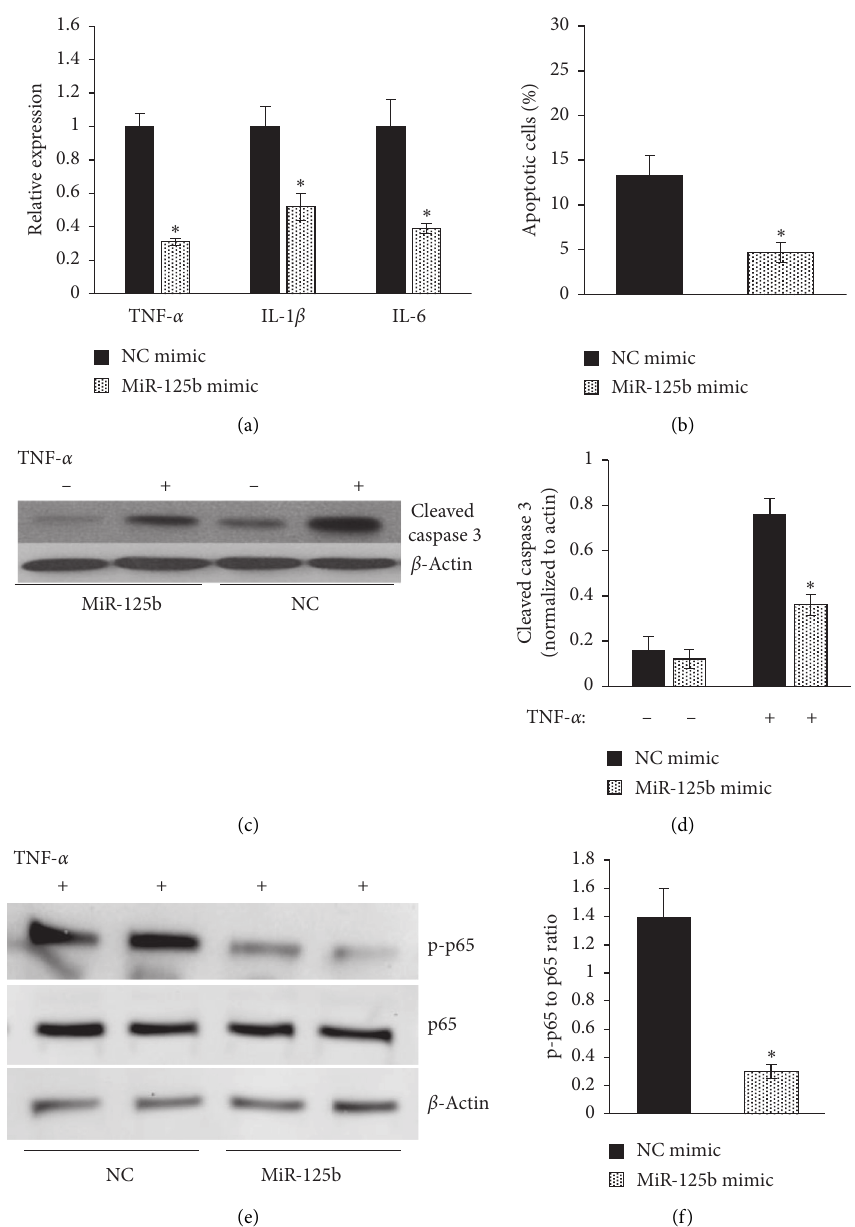
Figure 2: Upregulation of miR-125b in EPCs attenuated the expression of proinflammatory factors and ameliorated the TNF- α -induced cell apoptosis. EPCs were treated with TNF- α (10ng/mL) for 1h after transfection. The mRNA levels of proinflammatory factors (TNF- α , IL-1 β , and IL-6) were measured by qRT-PCR (a). Cell apoptosis was determined by flow cytometry using annexin V staining (b). The activation of caspase3 was analyzed by western blotting. Representative (c) and quantification (d) of caspase3 level (normalized to β -actin). The activation of NF- κ B was determined by the level of p-p65 in EPCs using western blotting. Representative (e) and quantification (f) of p-p65 level (normalized to p65) ( ∗ p < 0 . 05 vs. NC mimic with TNF- α treatment, n �